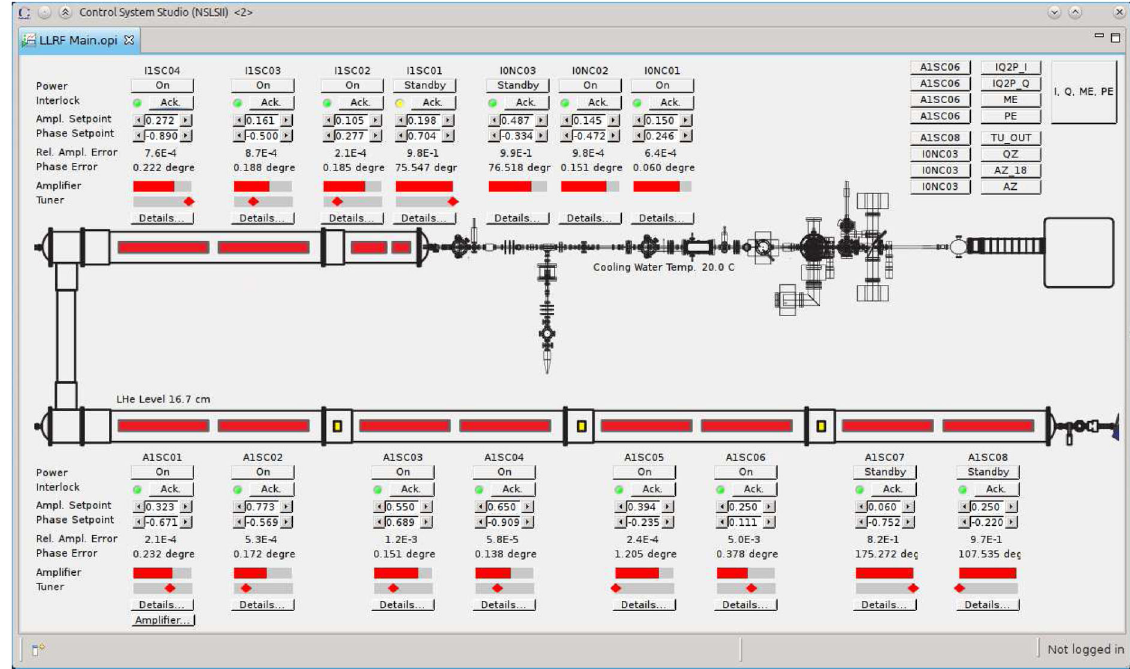
FIG. 4. Screenshot of the main display of the rf control system’s operator interface. It only provides the most frequently used controls and links to further displays for